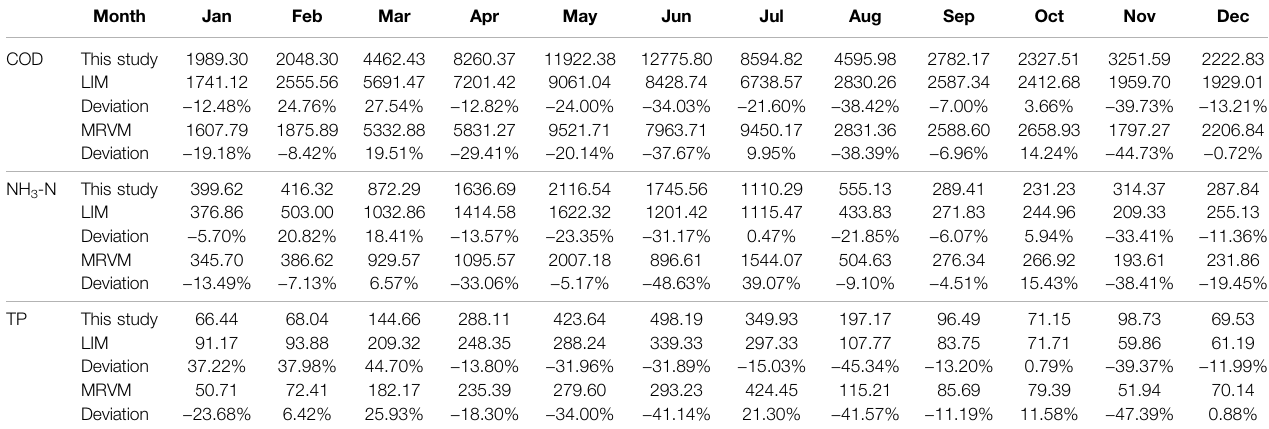
TABLE 5 | Comparison of monthly pollutant fl ux estimates obtained by different